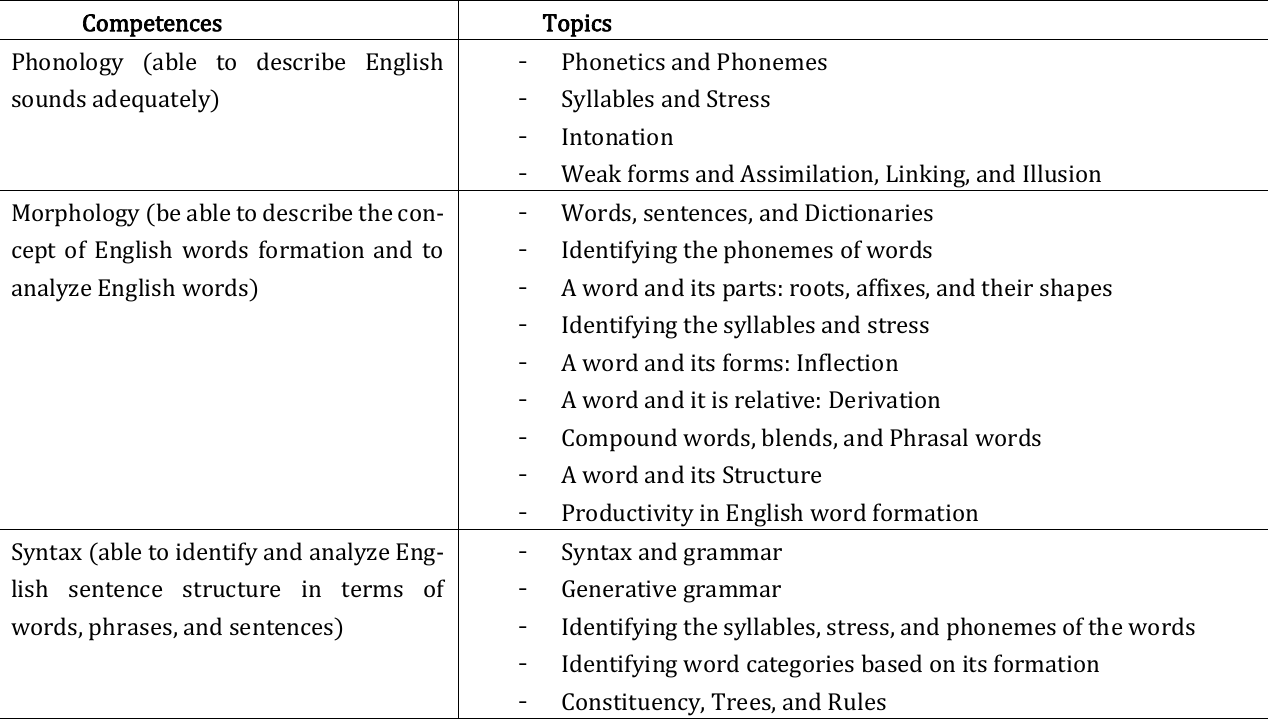
Table 1. Range of topics for Linguistics Description of English Competences Topics Phonology (able to describe